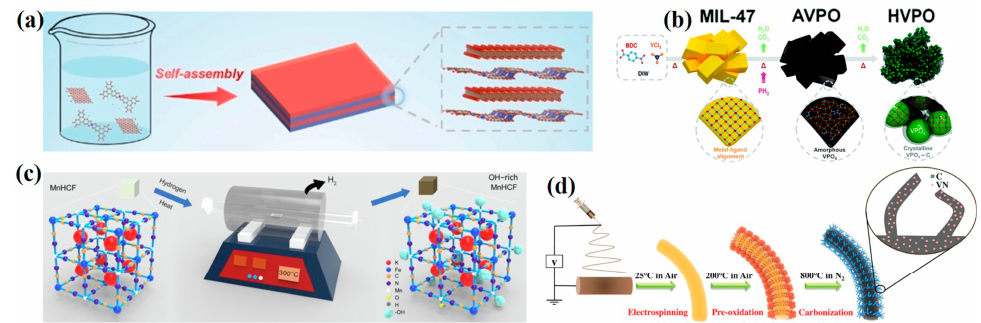
Figure 5. Schematic illustration of the formation process of ( a ) Cu-HHTP/MX [42]. Copyright 2023, John Wiley and Sons. ( b ) HVPO [74]. Copyright 2022, Royal Society of Chemistry. ( c ) OH-rich MnHCF [73]. Copyright 2023, Elsevier, and ( d ) VN/N-CNFs [75]. Copyright 2022, John Wiley and Sons.